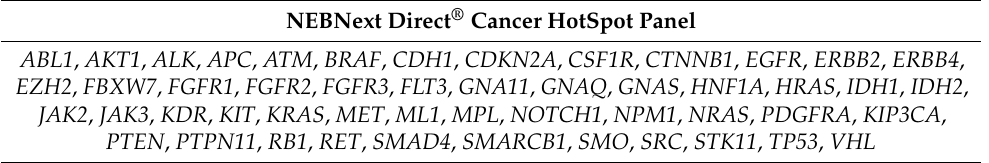
Table 2. List of cancer-related genes covered by next-generation sequencing panel.